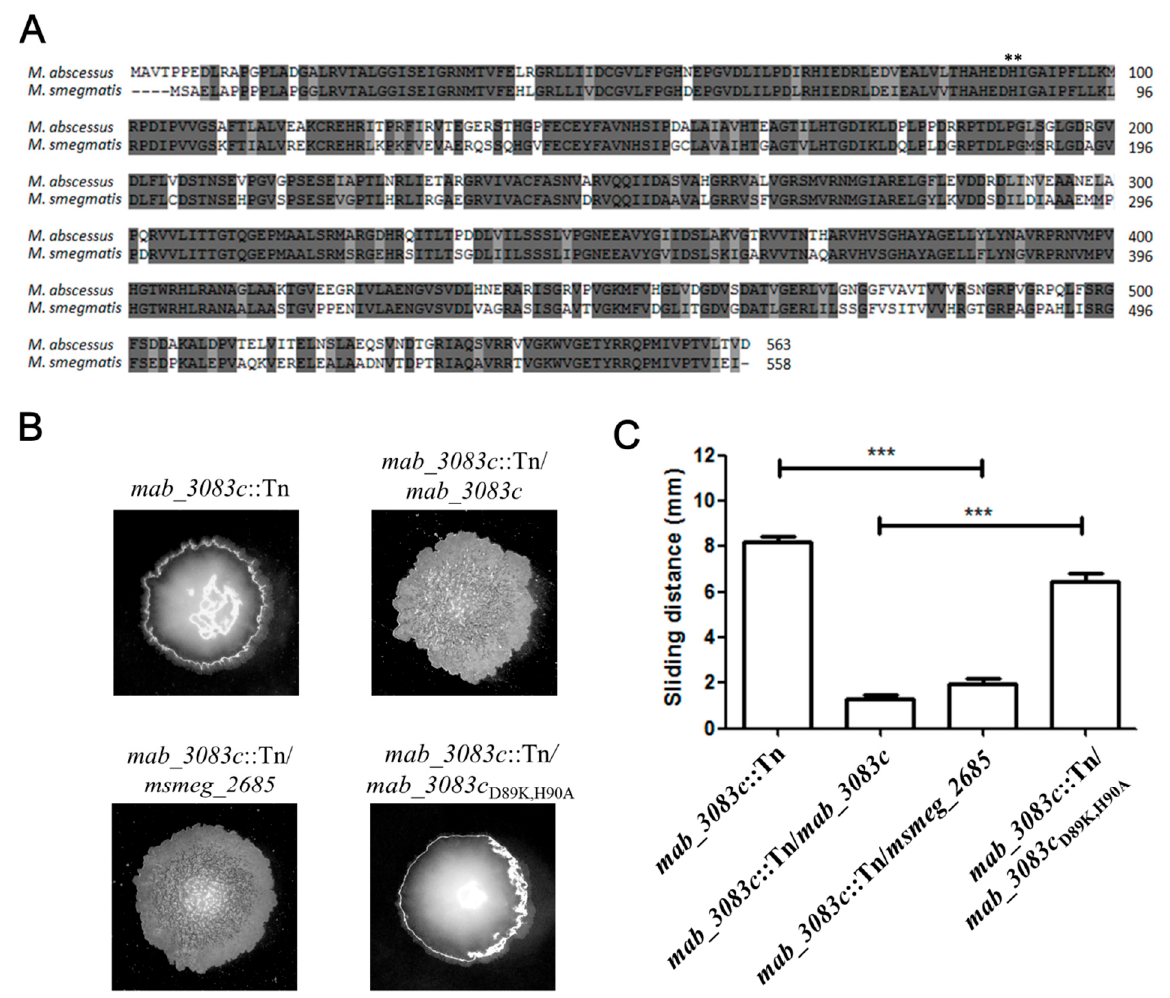
Figure 5. Identification of mab_3083c ( A ) Alignment of RNase J amino acid sequences of M. abscessus and M. smegmatis . Dark gray and light gray represent same and similar amino acid, respectively. Stars represent the mutation sites ( mab_3083c , D89, and H90). Sequences were downloaded from NCBI ( M. abscessus ID: NC_010397.1; M. smegmatis ID: NC_008596.1) and aligned using Vector NTI alignment X (Invitrogen, Frederick, MD, USA). Colony morphology ( B ) and sliding ability ( C ) of mab_3083c ::Tn, mab_3083c ::Tn/ mab_3083c , mab_3083c ::Tn/ msmeg_ 2685, and mab_3083c ::Tn/ mab_3083c D89K, H90A strains. Statistical analysis was performed by one-way ANOVA and Tukey’s multiple comparison tests. *** p <